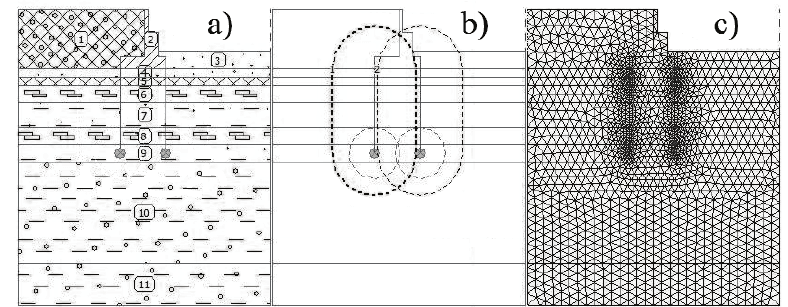
Fig. 1. Data adopted in GEO 5 v16 software: stratification of the subsoil (a), density zones of finite elements (b), mesh of finite elements